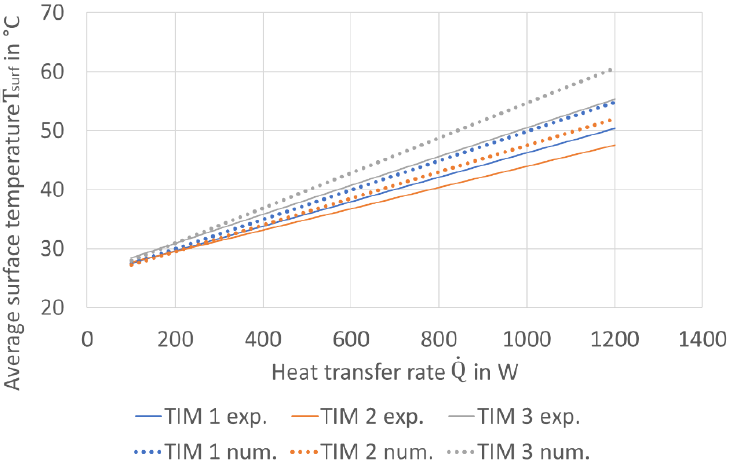
. m = 86.5 g/s, T in = 25 ◦